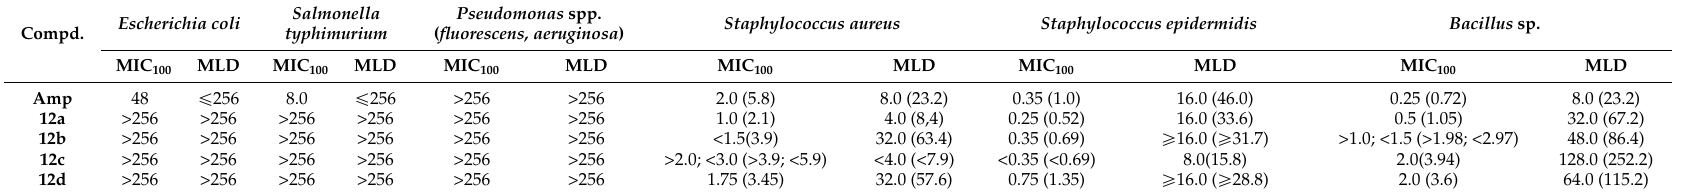
Table 1. Minimal inhibitory concentration (MIC) and Minimal lethal dose (MLD) as µ g ¨ mL ´ 1 . The numbers in parentheses indicate the molar concentration ( µ M).